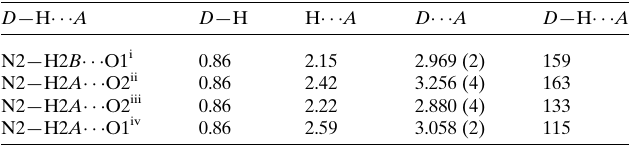
Table 1 Hydrogen-bond geometry (A˚ , (cid:5) ).